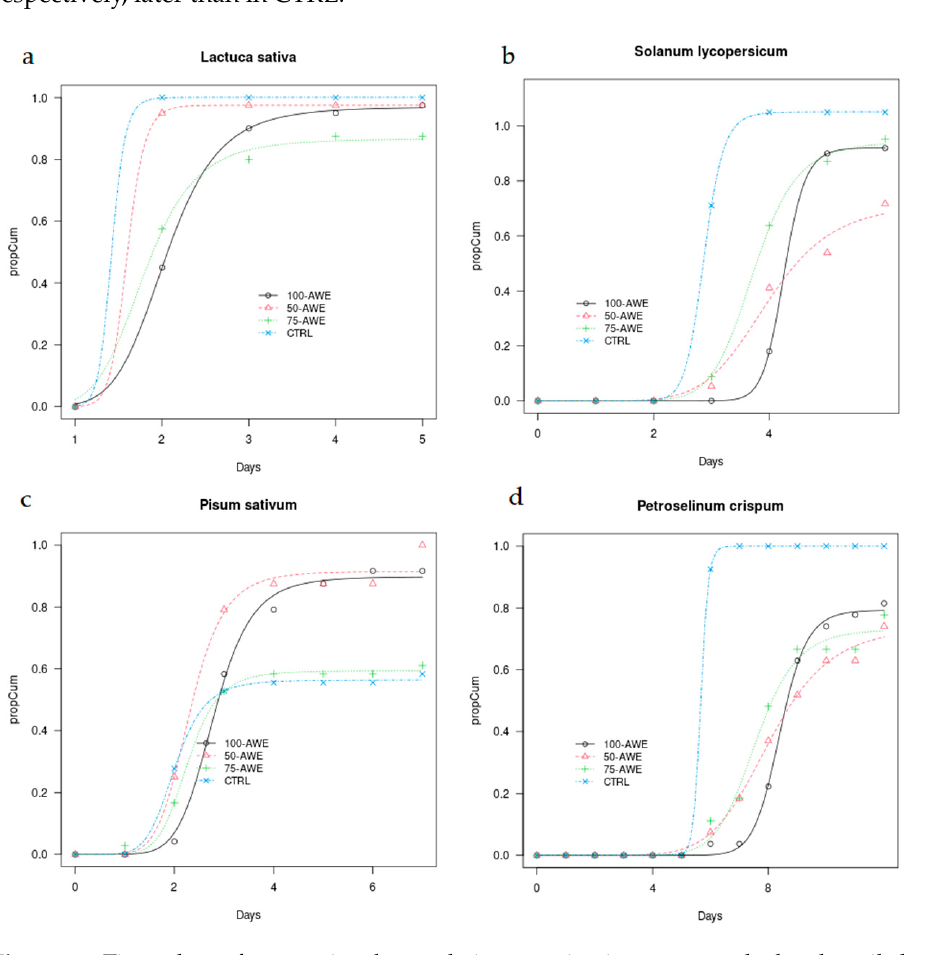
Figure 2. Time plots of proportional cumulative germination curves calculated until the end of the monitoring for horticultural species ( a ) Lactuca sativa L., ( b ) Solanum lycopersicum L., ( c ) Pisum sativum L., ( d ) Petroselinum crispum (Mill.) under AWE treatments (50% AWE, 75% AWE, 100% AWE) and control (CTRL).